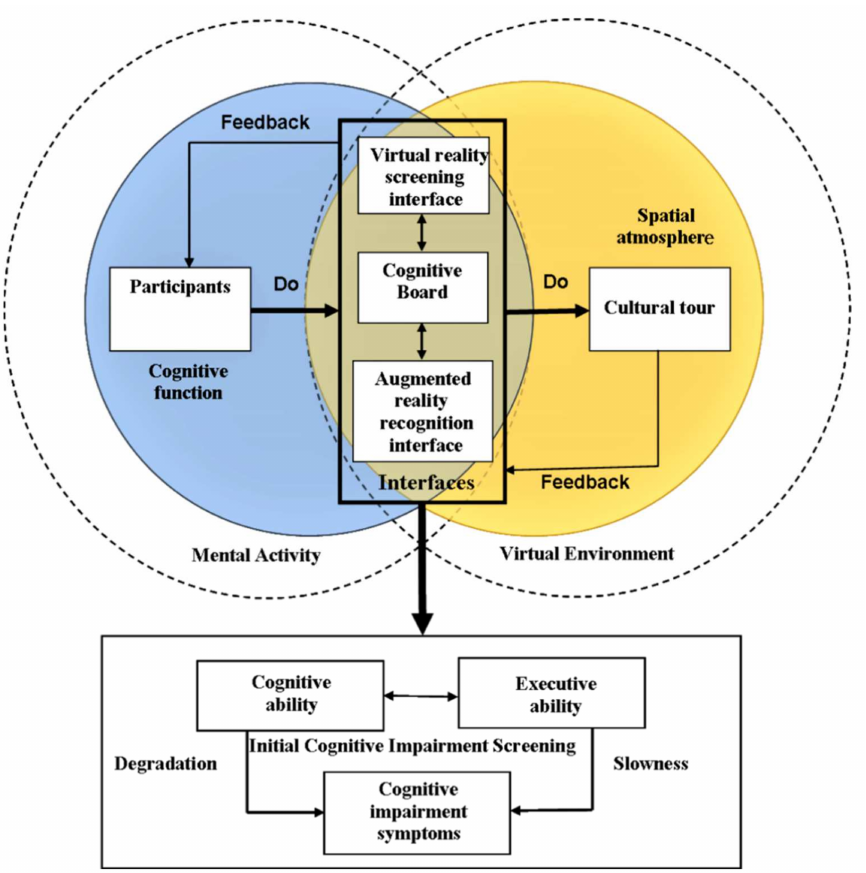
Figure 1. Architecture of the virtual scenario initial dementia cognitive screening (VSIDCS) system in a virtual cultural